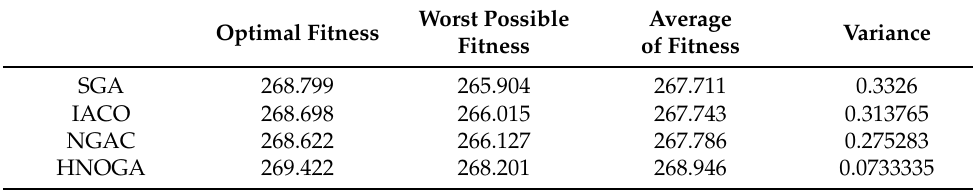
Table 5. Experimental results of crossover operator performance